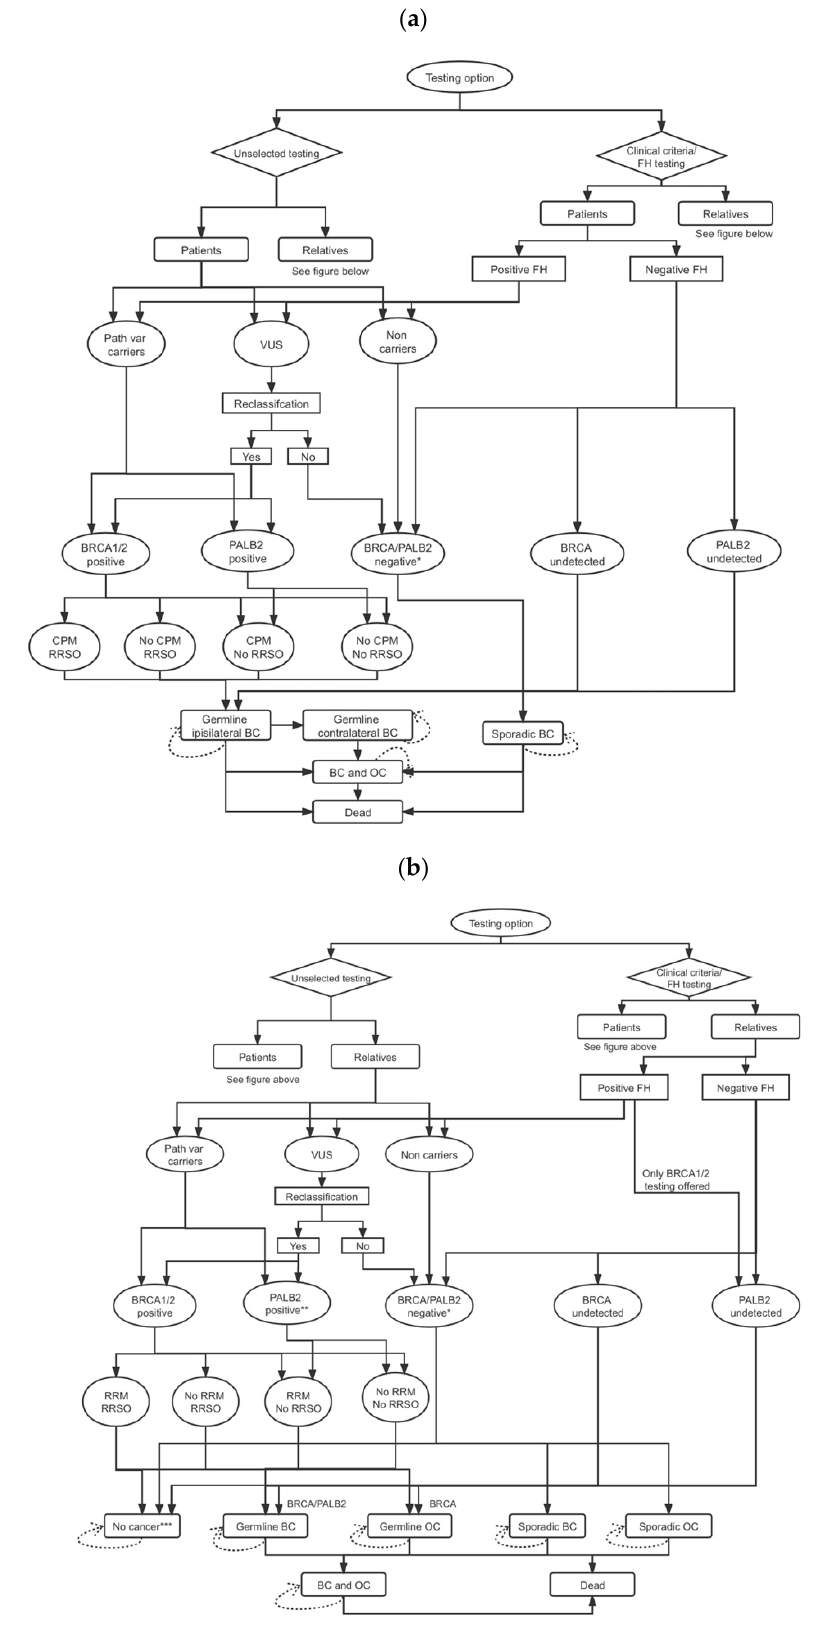
Figure 1. Model structures for unselected and FH/clinical-criteria-based genetic testing for BC patients and relatives: ( a ) for BC patients; ( b ) for relatives of BC patients. Abbreviations: BC,